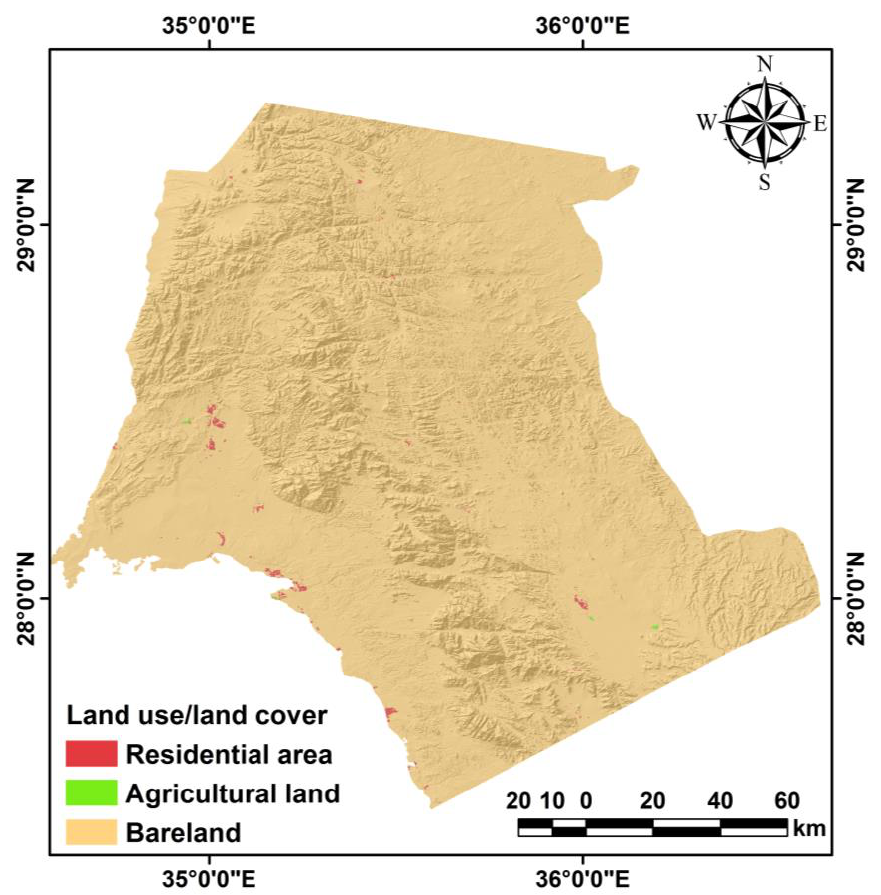
Figure 7. Land use/land cover map showing that the Neom area is a typical desert area primarily made up of bare land. The residential and agricultural areas represent less than 1% of the total area.